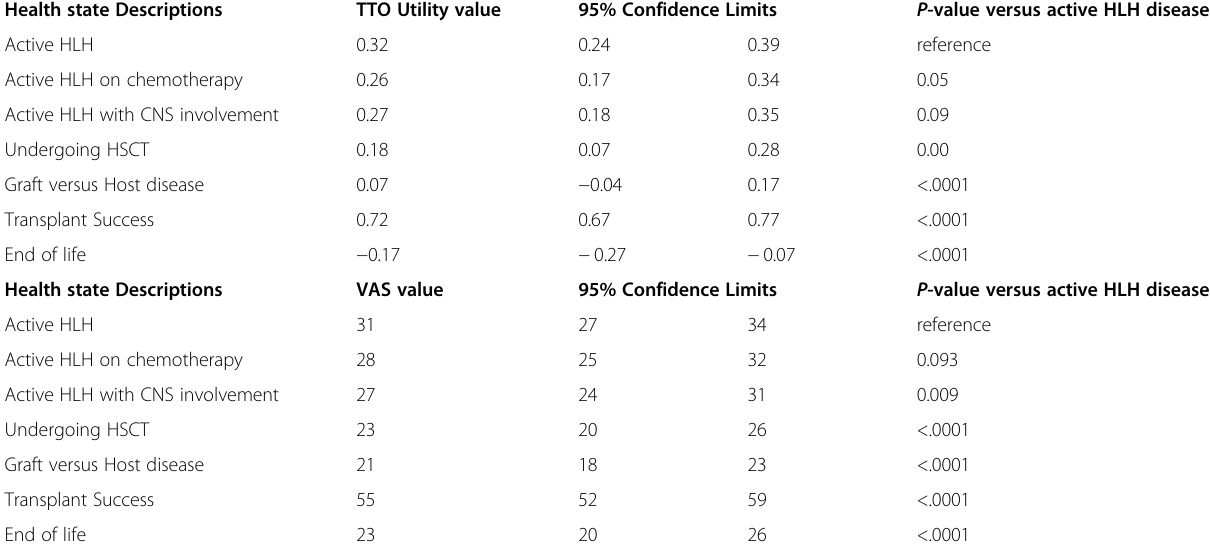
Table 3 Estimated utilities or preference weights from TTO and VAS assessments of the HLH